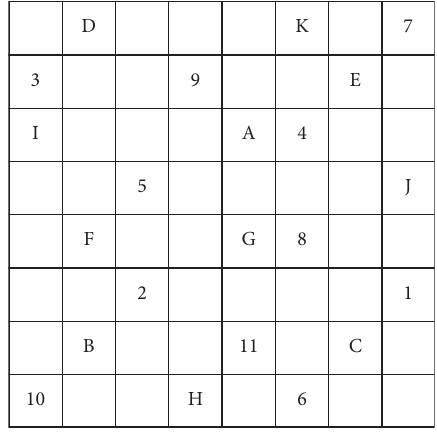
Figure 6: Conceptual illustration of the trails